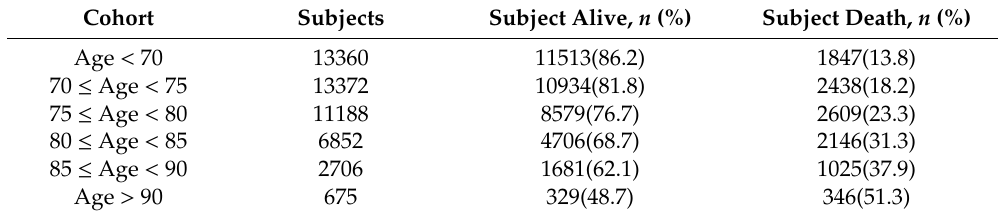
Table 7. The separate cohorts that the models were evaluated on.